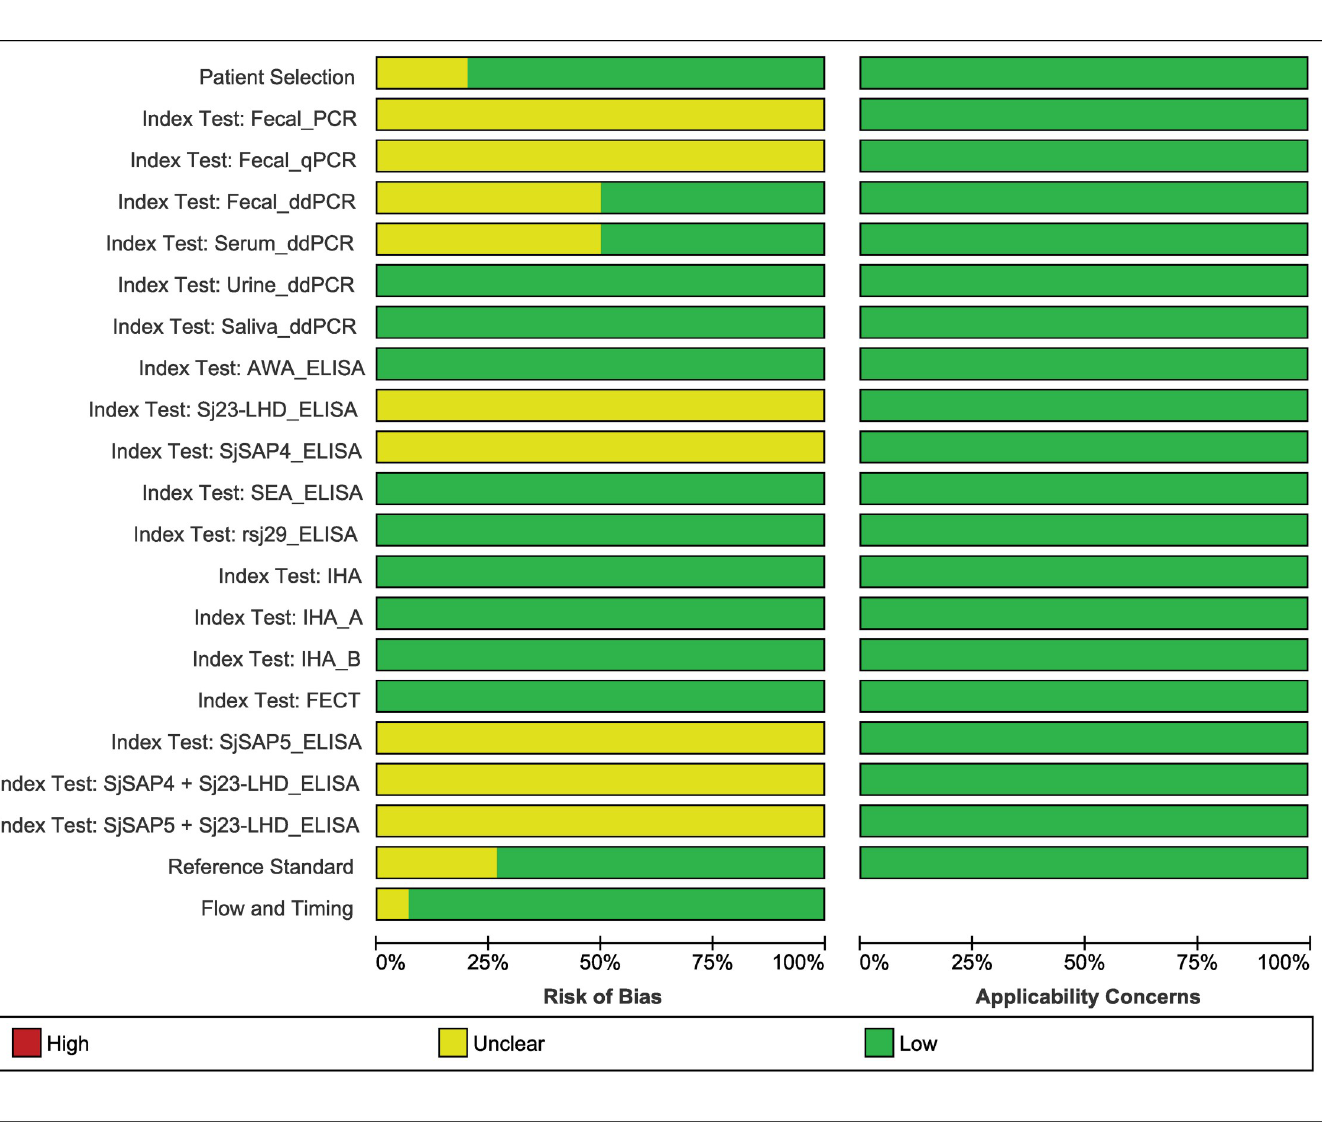
Fig 8. Risk of bias and applicability concerns graph: each domain presented as percentages across included